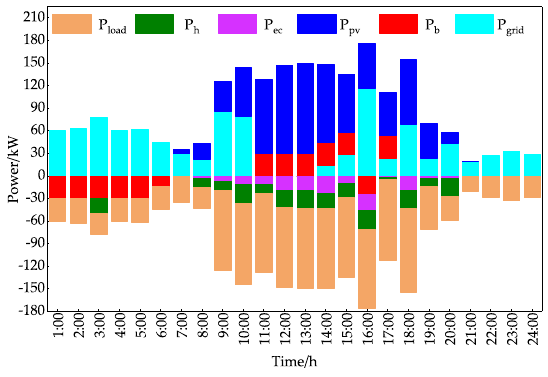
Figure 10. The optimal scheduling results when EWHVES and ACVES are